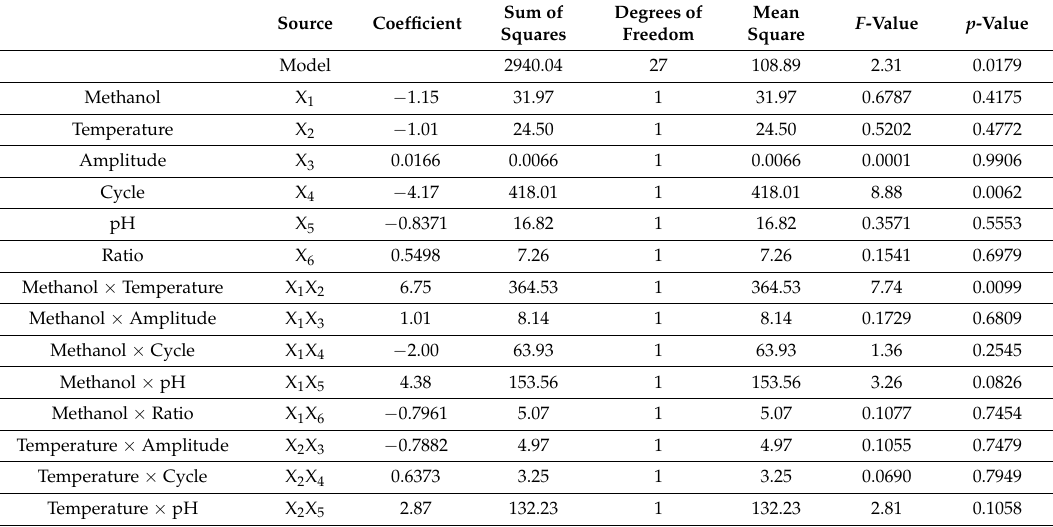
Table 2. ANOVA for the quadratic model adjusted to the extraction of total phenolic compounds. Source